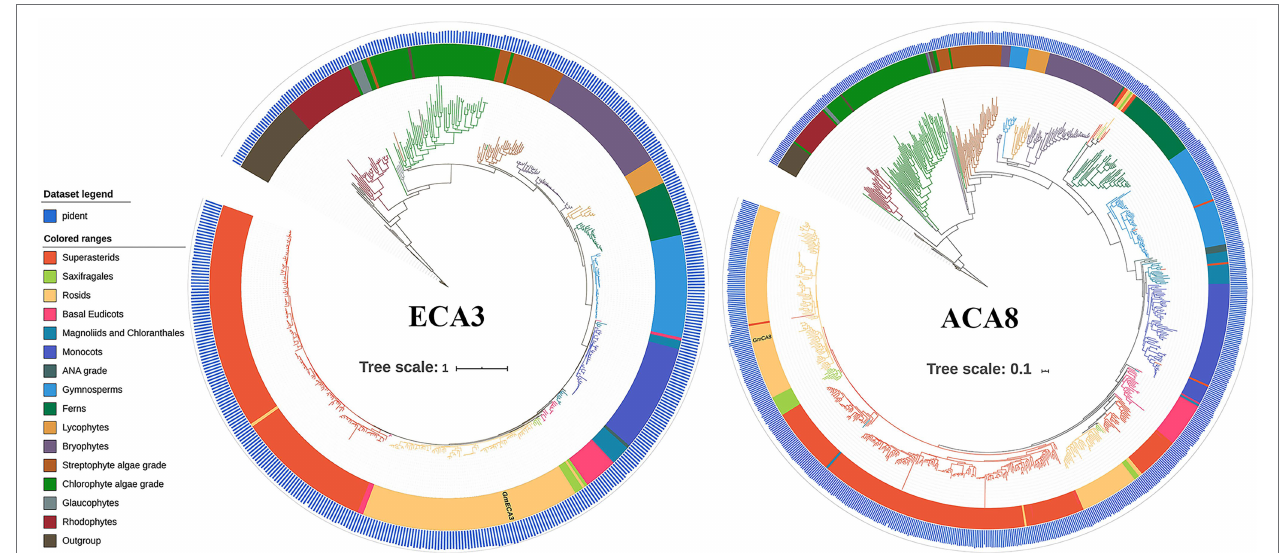
FIGURE 2 | Phylogenetic analysis of GmACA8 and GmECA3. Genes sampled from Chromia algae were used as the outgroup (in the shade of dark brown) and the root of the tree, and the Interactive Tree of Life resource was used to annotate gene trees. The location of GmACA8 and GmECA3 were shown on the phylogenetic trees. The blue bar chart outside the phylogenetic tree represents the percentage of identical matches, which is range from 0 to